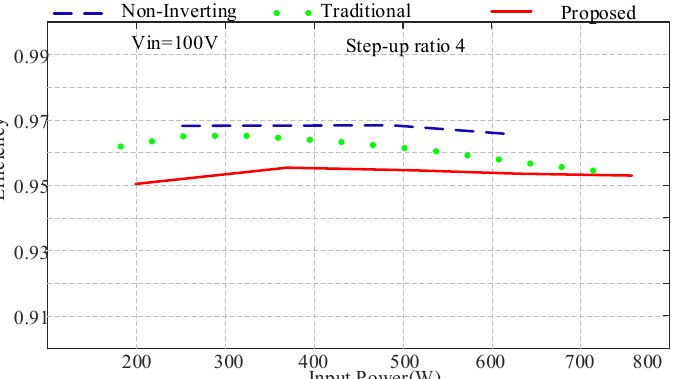
Figure 16. Measured efficiency comparison between the proposed converter, non-inverting buck- boost, and traditional buck-boost converter at a step-up ratio of 3.7.